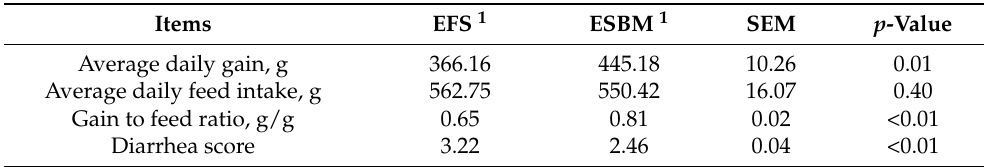
Table 2. Effects of enzyme-treated soybean meal replacing extruded full-fat soybean on performance of nursery pigs.